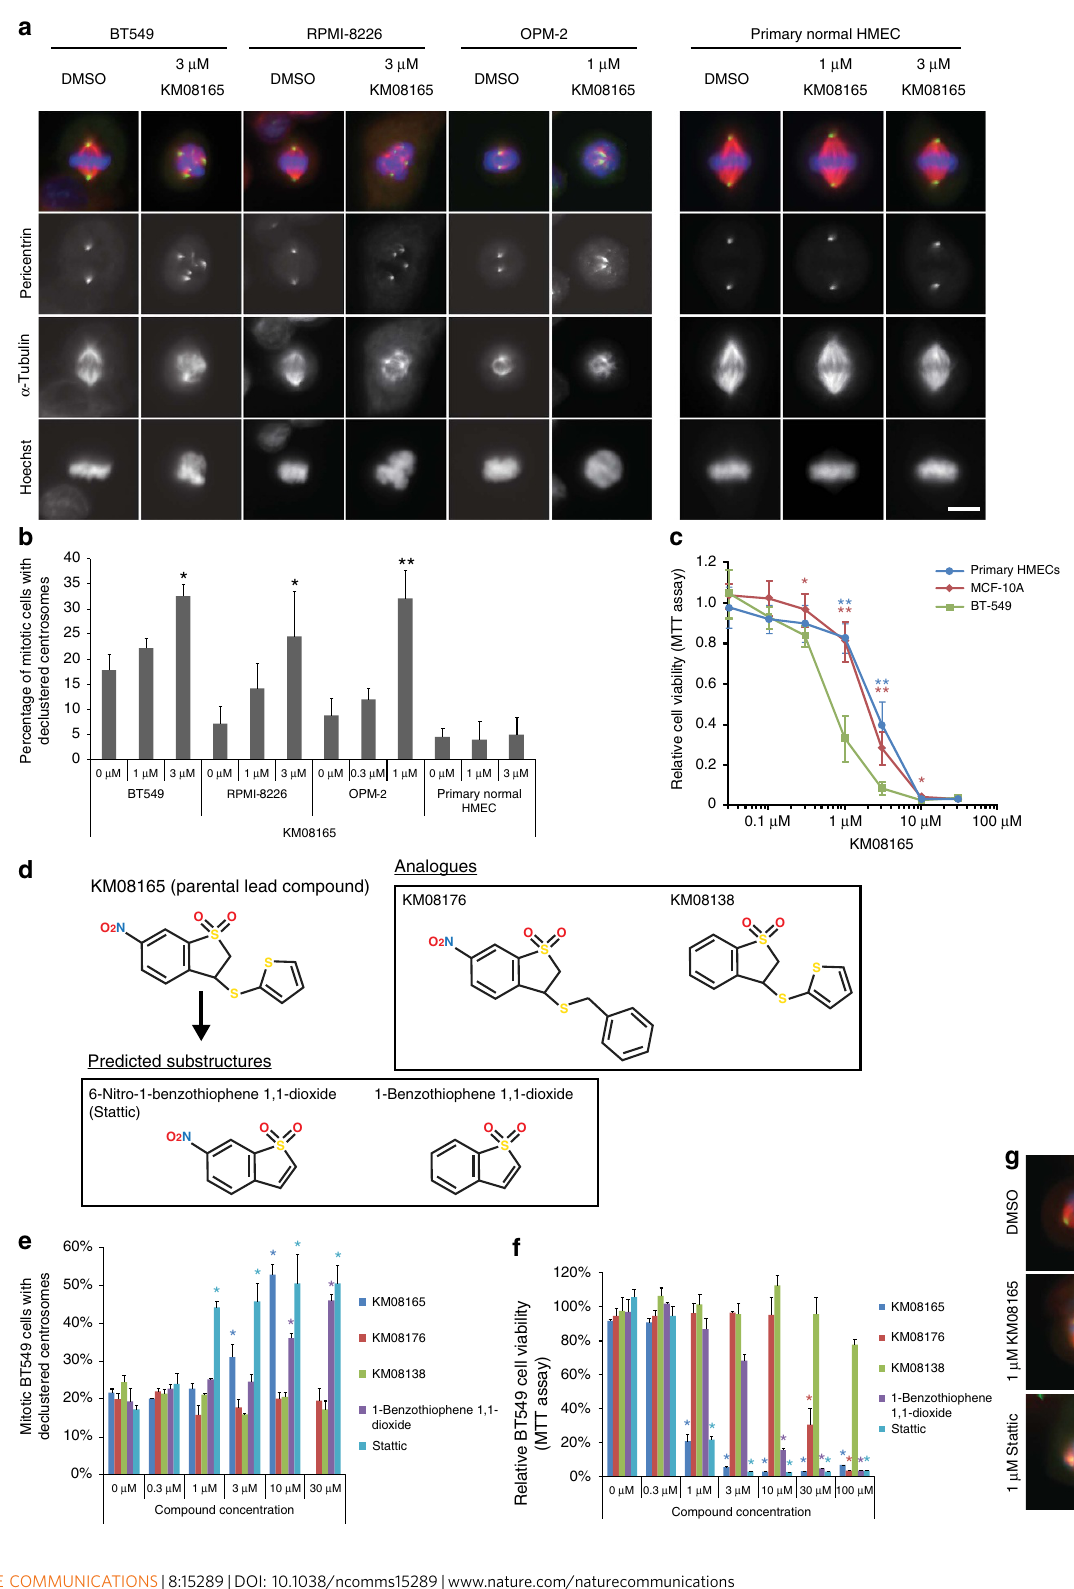
NATURE COMMUNICATIONS|8:15289|DOI: